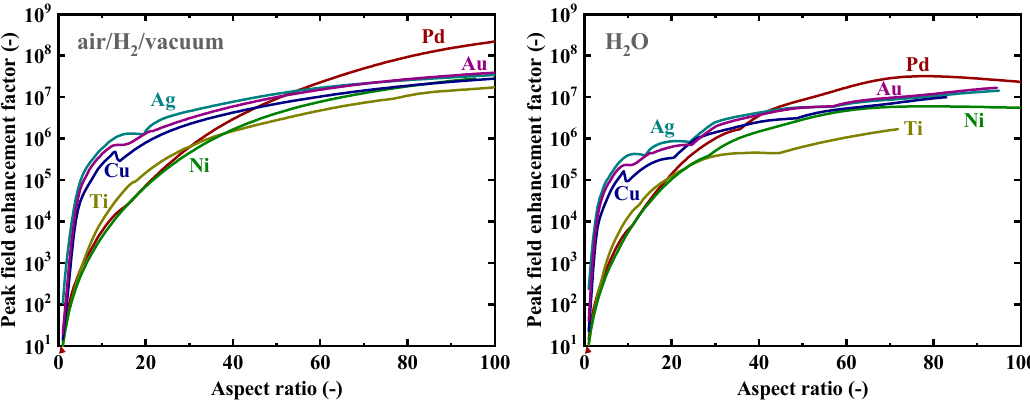
Figure 6. Dependence of the peak electromagnetic field enhancement factors at the tips of spheroidal nanoparticles of Au, Ag, Cu, Pd, Ti, and Ni on the aspect ratio in ( left ) air / H 2 / vacuum and ( right ) H 2 O.